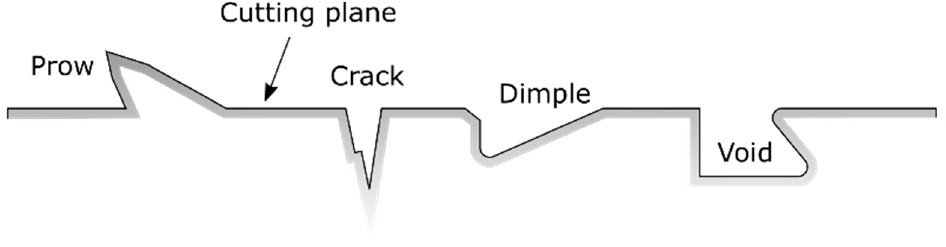
Figure 3. Surface faults in micro-milling .